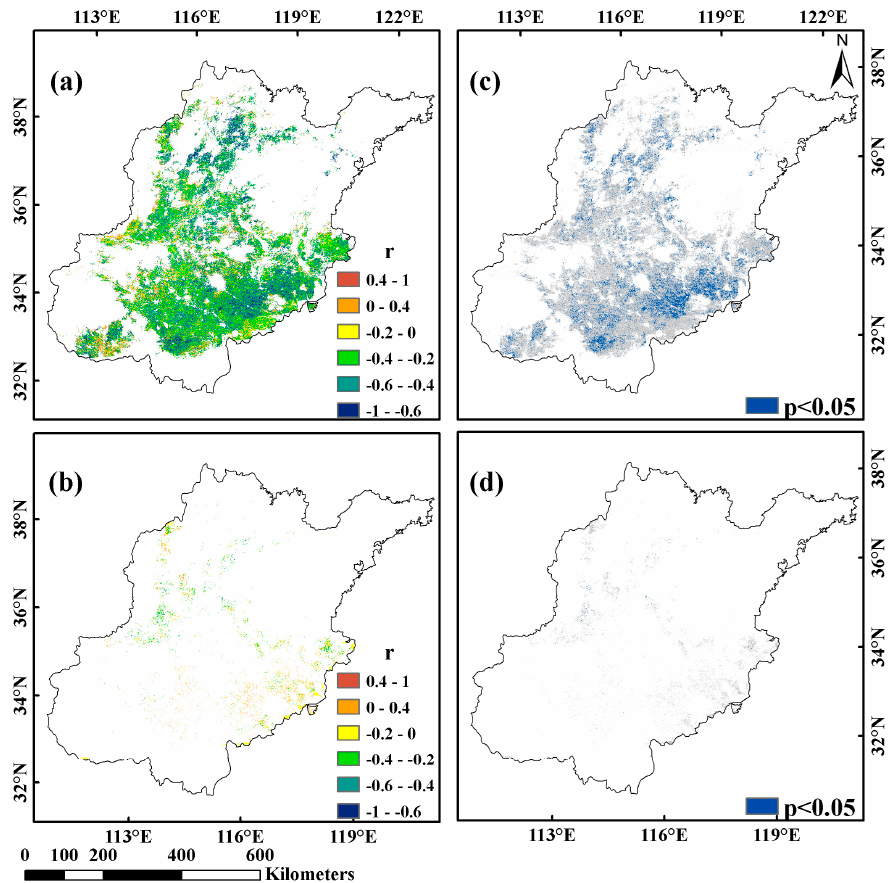
Figure 8. The Pearson correlation coe ffi cients (r) of the March–April mean temperature with the HD ( a ) and the May–June mean temperature with the LRGP ( b ). There is corresponding significance at the 0.05 statistical level ( c , d ). The gray pixels represent where the correlation is not significant ( p >